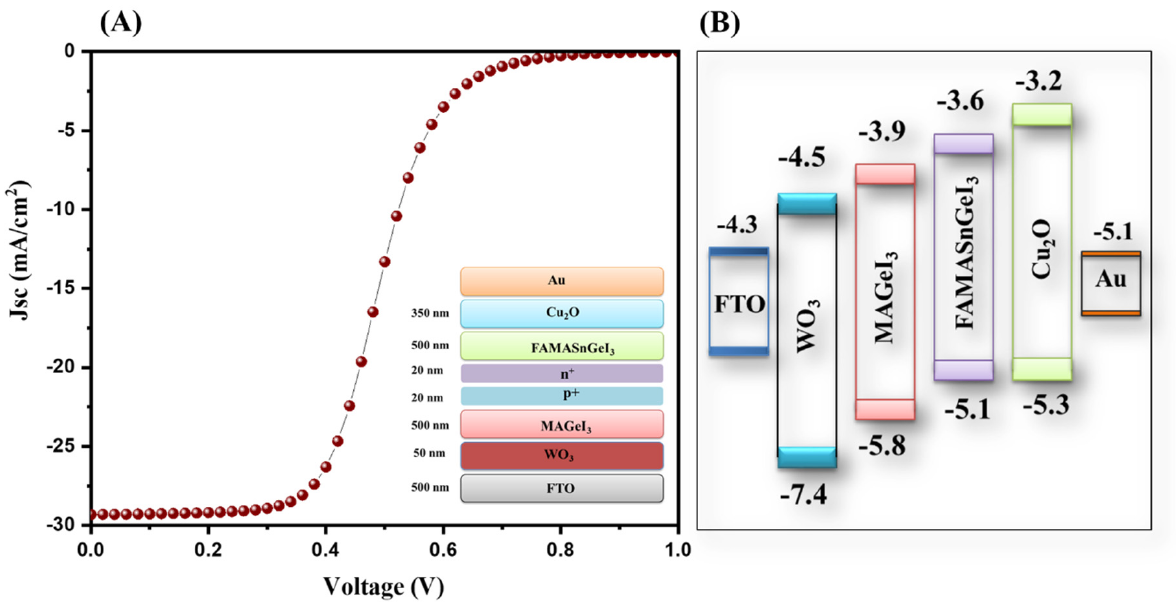
Figure 9. J–V curve ( A ) and energy level diagram ( B ) of tandem solar cells with WO 3 as the ETL.